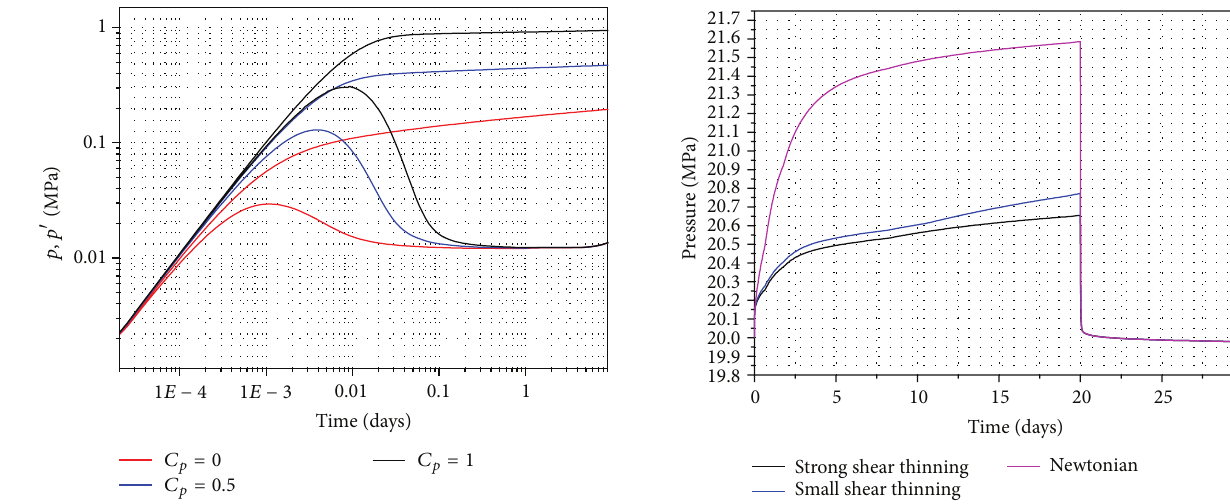
Figure 5: BHP of the injection well for different 𝑀 - 𝑉 curves with the same injection polymer concentration of 1.5 kg/m 3